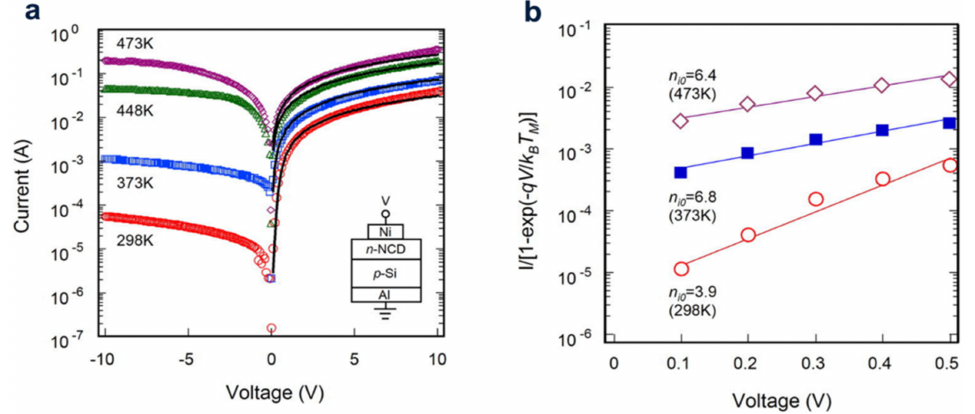
Figure 10. ( a ). At TM = 298, 373, 448, and 473 K, the series resistance RS used in the fitting were 36 × , 130, 55, and 300, respectively. I-V measurement of the n-NCD/p—Si heterojunction properties with TM variation. The real curve is obtained by using equation fitting at n i = 2.4 for each TM. ( b ) Draw (cid:16) (cid:17) − qV 1 − exp curve of TM with V. When TM = 473, 373 and 298 K, the straight lines are fitting k B T M curves of n i0 = 6.4, 6.8 and 3.9,